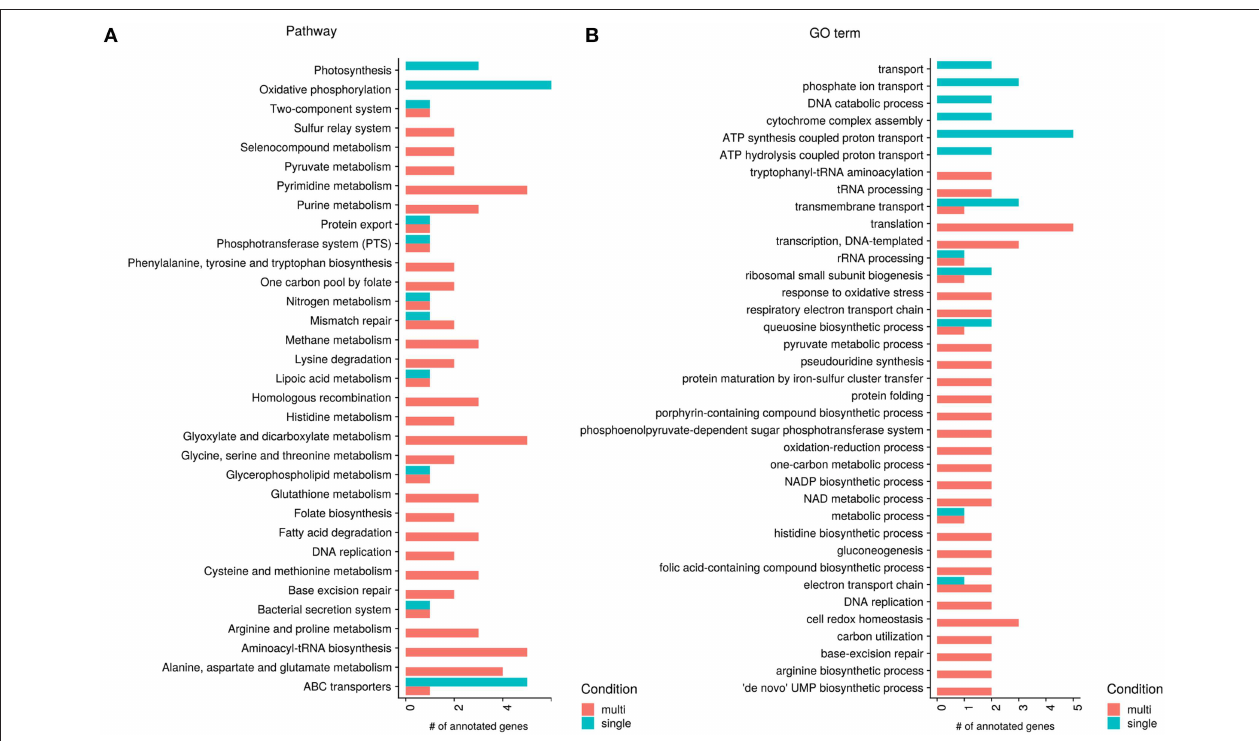
FIGURE 5 | Significant genes between single- and multi-species conditions annotated to KEGG pathways and GO terms (molecular function). Shown are all KEGG pathway (A) and GO molecular function (B) annotations with at least two genes separated by higher expression in single- or multi-species samples. Red bars show higher expressed processes in the multi-species samples and green bars higher expression in the single species